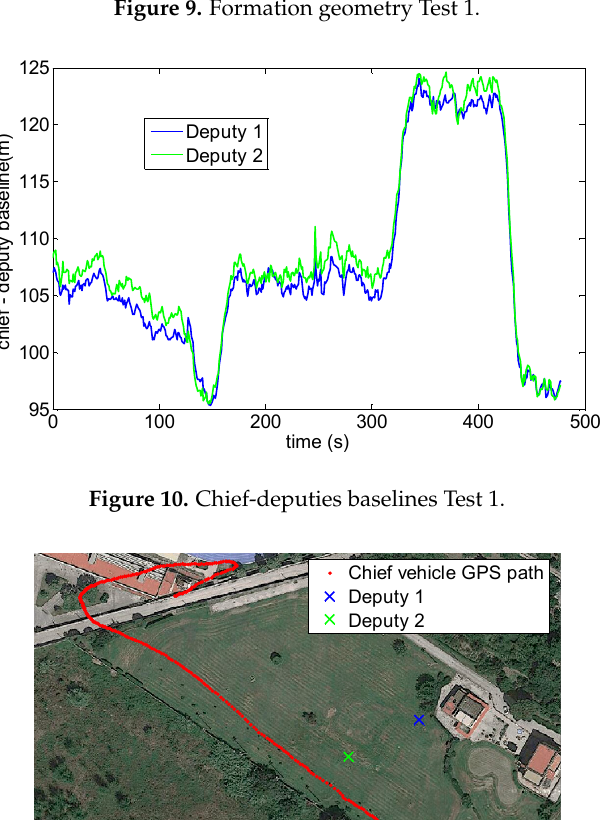
Figure 11. Formation geometry Test 2.